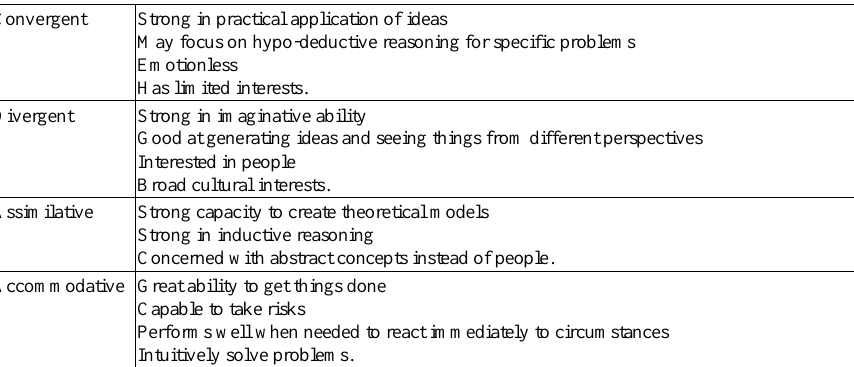
Table 2. Description of the learning styles characteristics, adapted from [43]